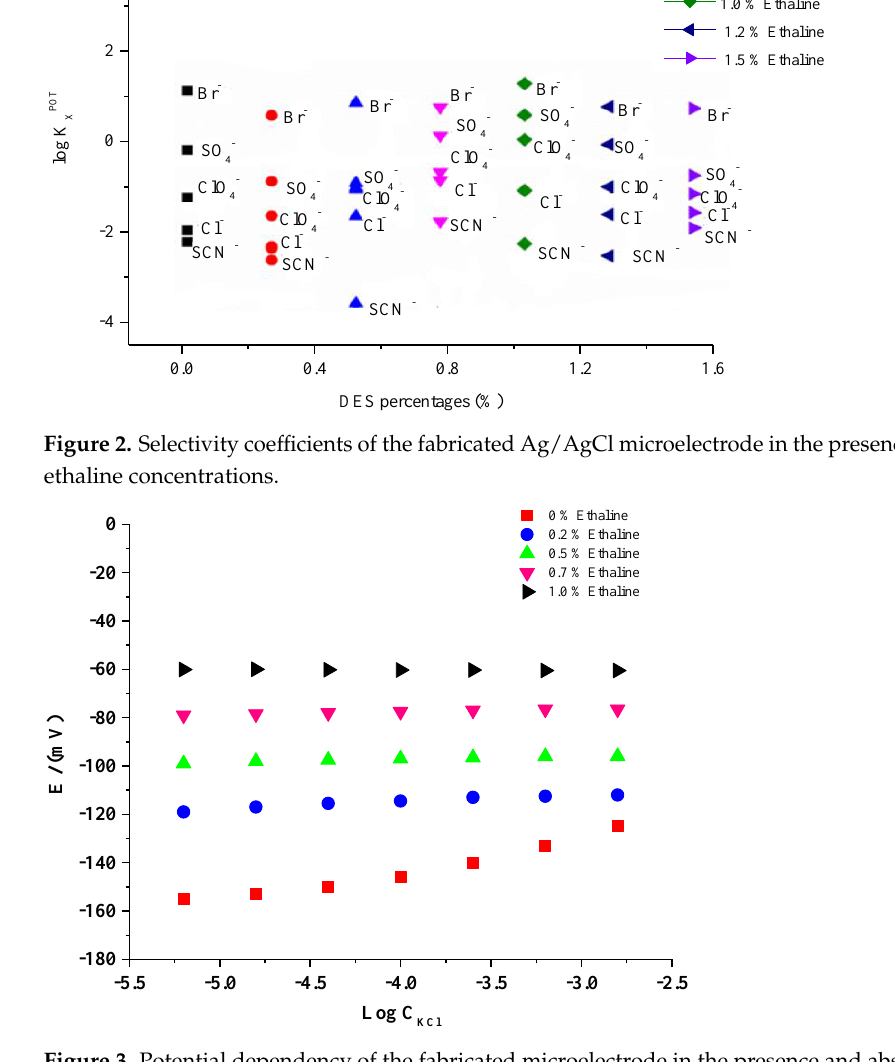
Figure 3. Potential dependency of the fabricated microelectrode in the presence and absence of DESs under various concentrations of KCl obtained in 20 mM Na 2 SO 4 .